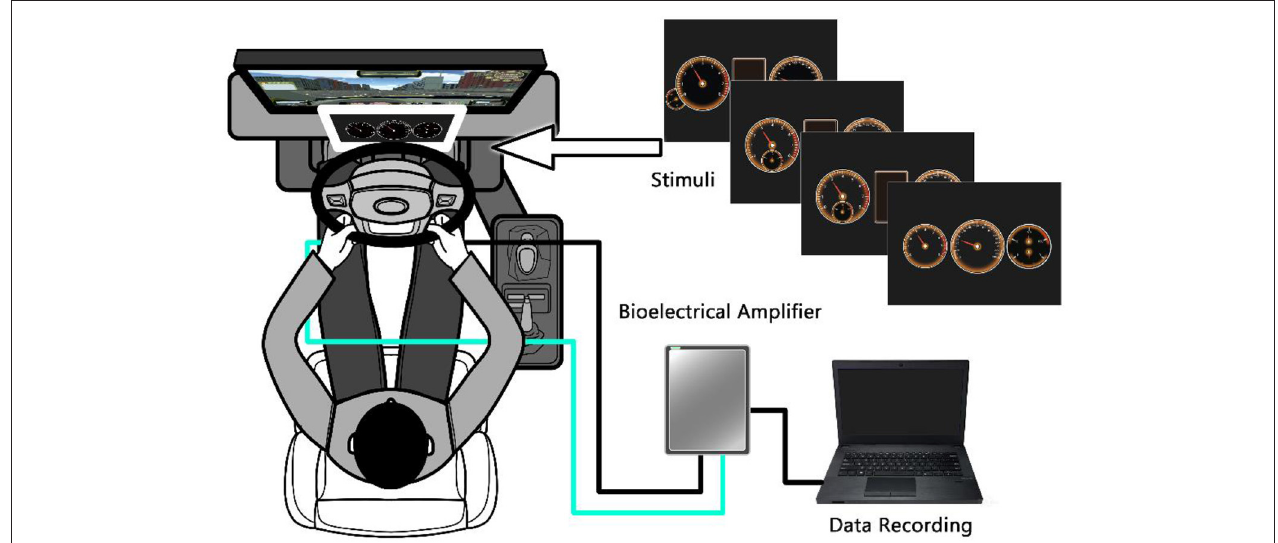
FIGURE 1 | Diagram of experimental